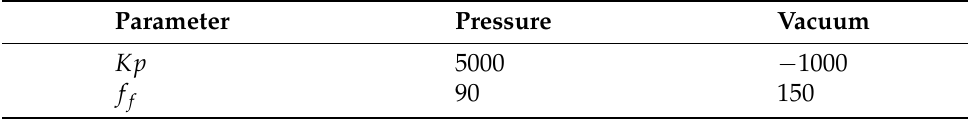
Table 3. Pressure controller properties.